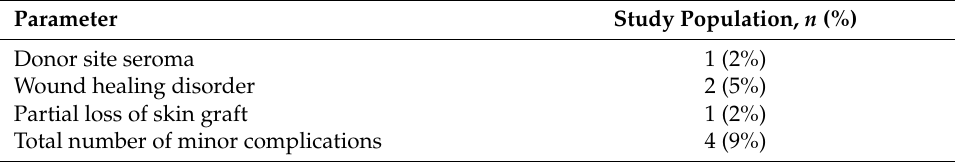
Table 2. Minor complications.